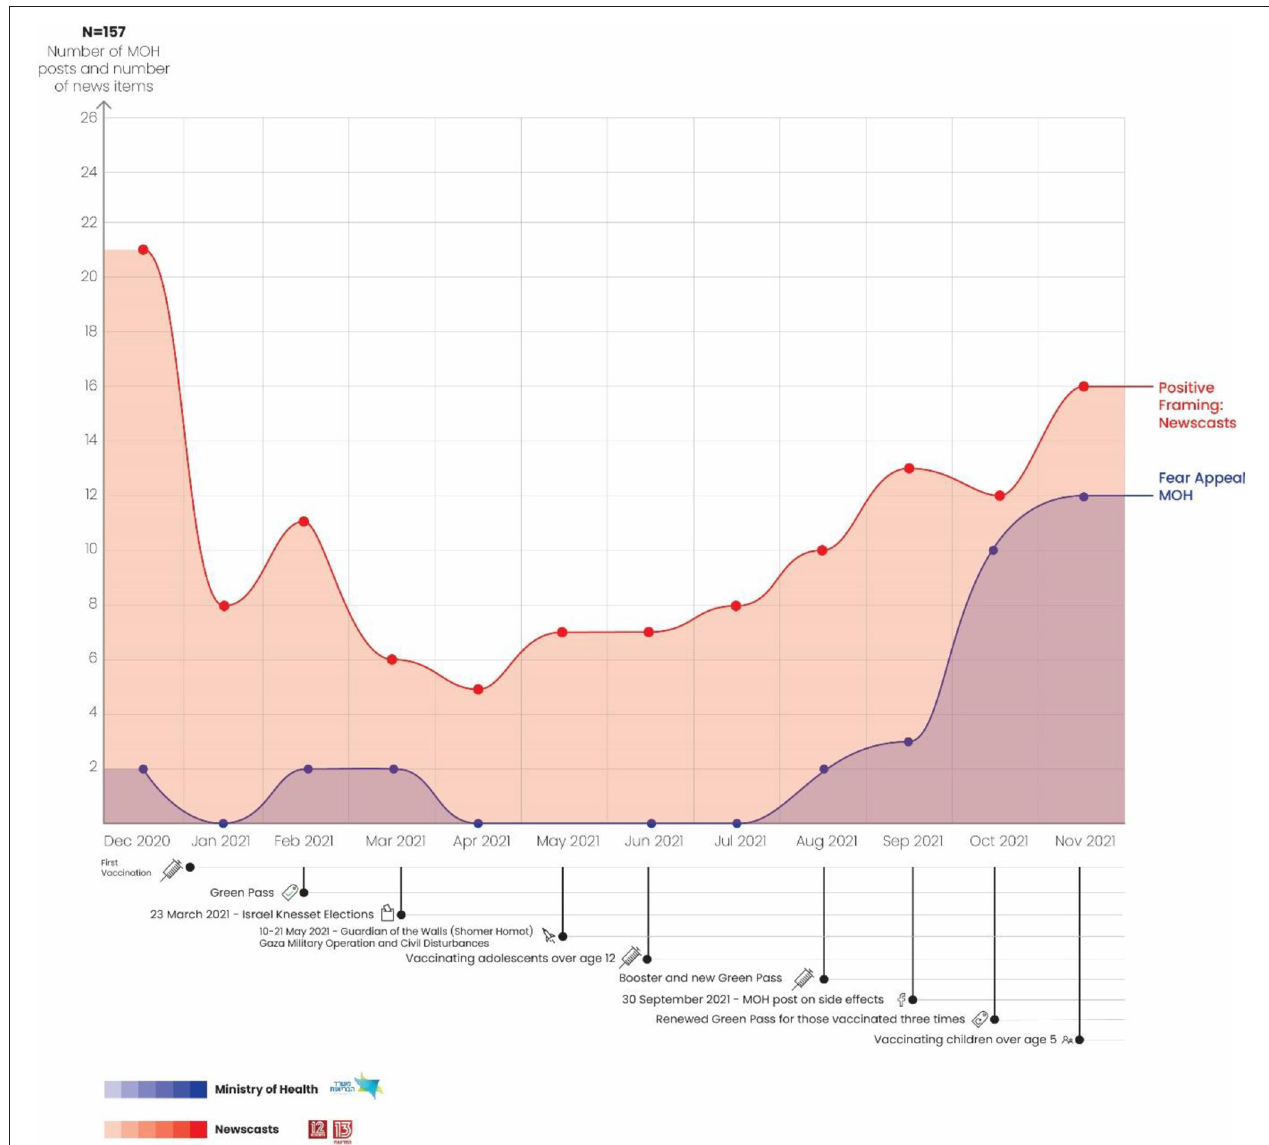
FIGURE 5 | Use of positive framing strategy on the news vs. MOH use of fear appeal